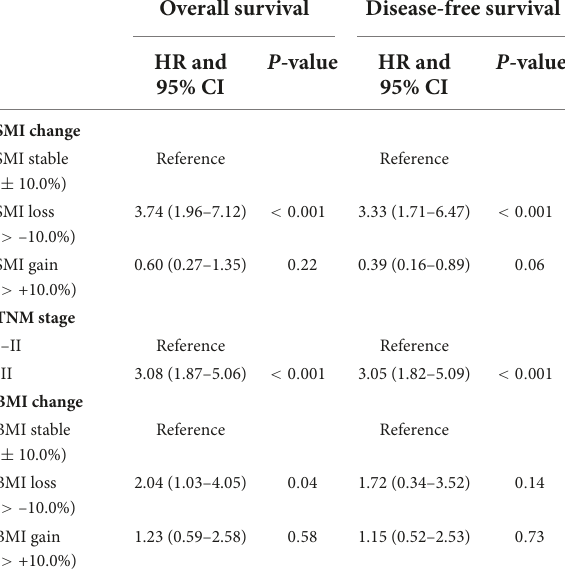
TABLE 3 Multivariate analysis for overall survival and disease-free survival ( n =